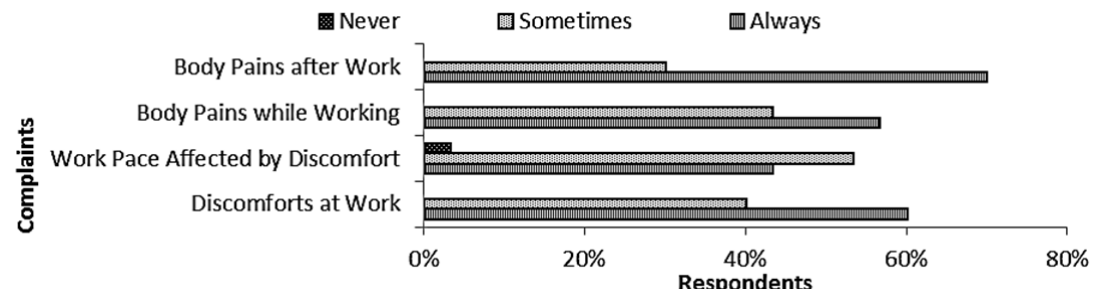
Figure 1 . Complaints of workers in small-scale feed mills.